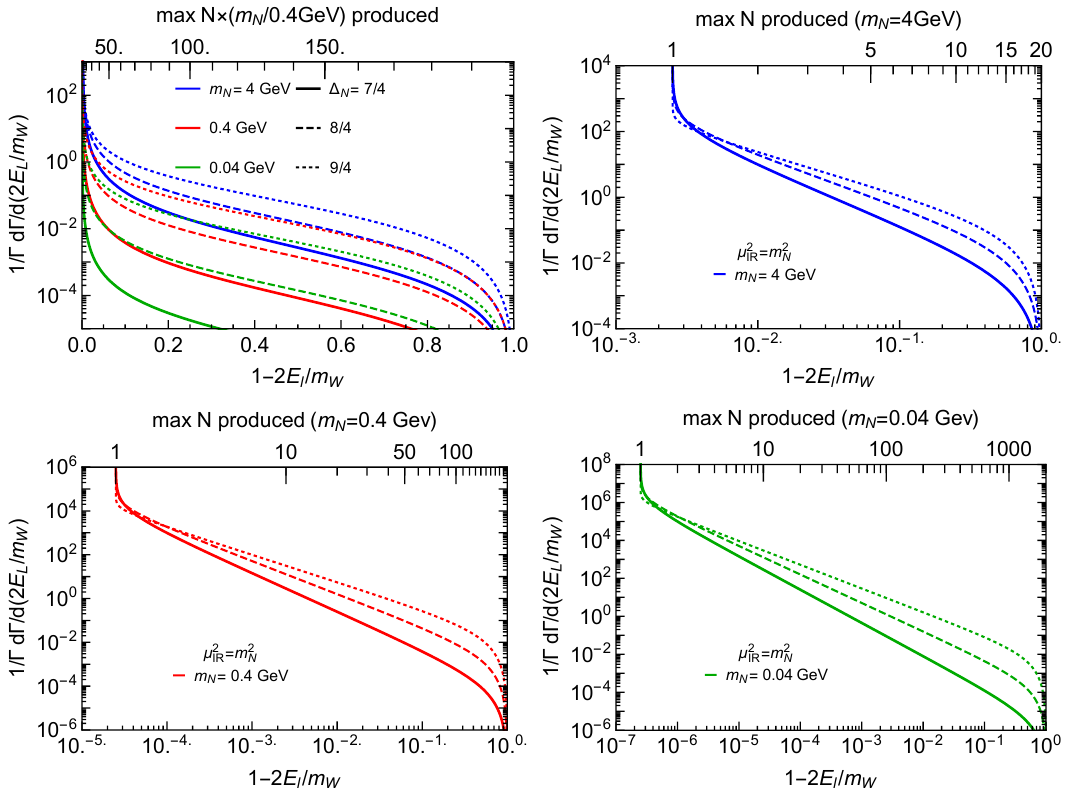
| U N | 2 , for α α ‘ . N